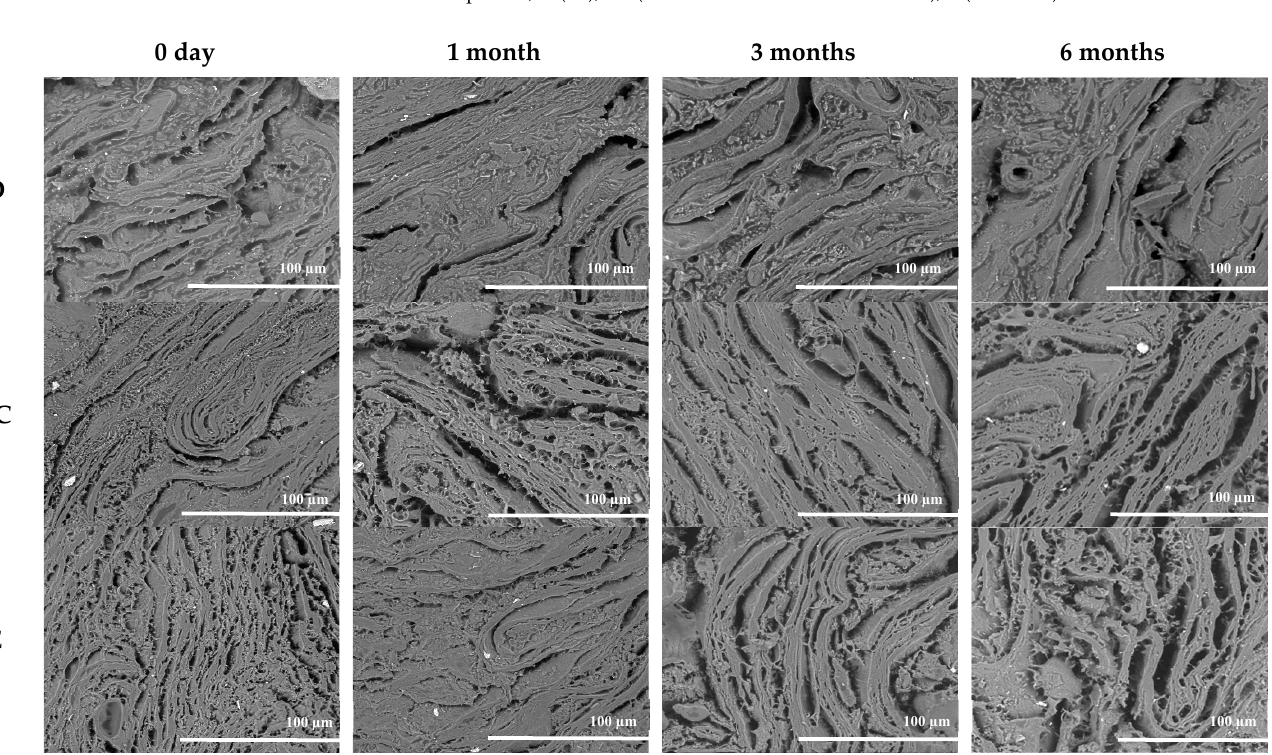
Figure 2. Microstructure of meat analogs with different fat replacers (O, EC, and E) during the freezing storage ( − 18 °C) for six months (500).